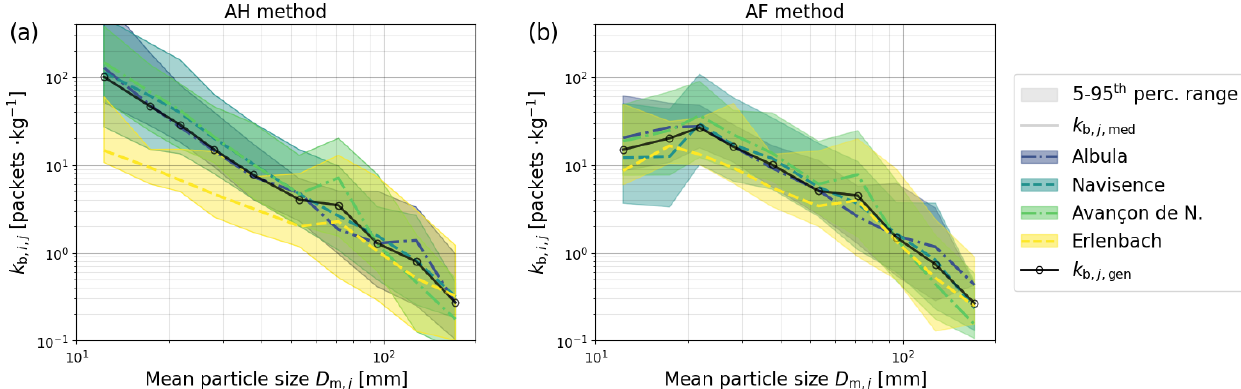
Figure 8. The k b ,i,j calibration coefficients obtained with the AH method (a) and the AF method (b) for each field site. The colored areas indicate the range between the 5th and 95th percentile k b ,i,j values, the full lines indicate the site-specific median coefficients k b ,j, med , and the black dashed lines indicate the final general calibration coefficients k b ,j, gen as a function of the mean particle diameter D m ,j of each grain-size class j . Table 5. Performance of the AH method and the AF method regarding fractional flux estimates for each class j with the following parameters: the linear coefficient a , the exponent b and the correlation coefficient r of the power-law regression lines visible in Fig. 9, the coefficient of determination R 2 , the root mean square error RMSE, and the percentage of all detected samples for which the estimated value differs from the measured value by less than a factor of 2 and 5 p factor_2 and p factor_5 , respectively. These values were first computed for each site separately and then averaged over all four sites. The number of measured N samples , meas and the number of estimated samples N samples , est showing a positive unit fractional rate were summed over all four sites.